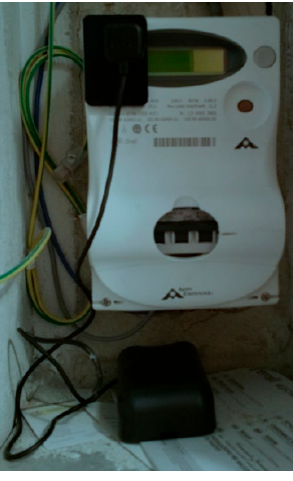
Figure 3. The power meter transmitter for the energy consumption measurement.